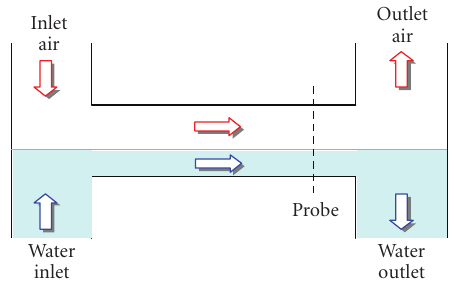
Figure 1: Experimental facility—conceptual